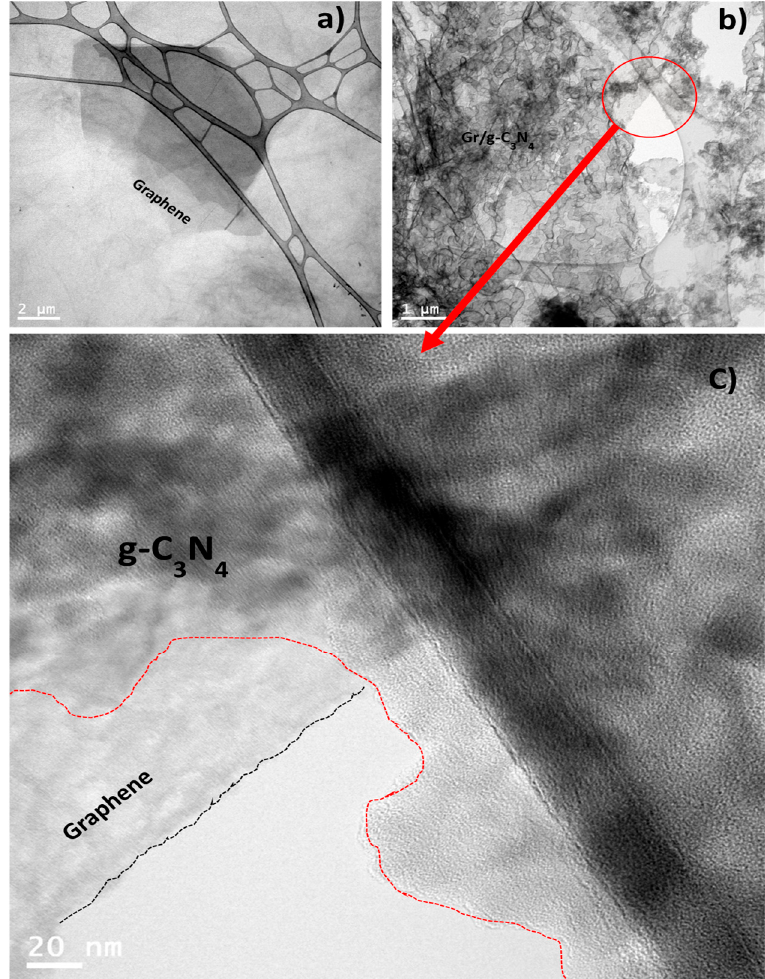
Figure 4. TEM images of ( a ) the graphene sheet, ( b ) the Gr/g-C 3 N 4 composite samples and ( c ) high resolution of a selected area (red arrow) of the Gr/g-C 3 N 4 composite.